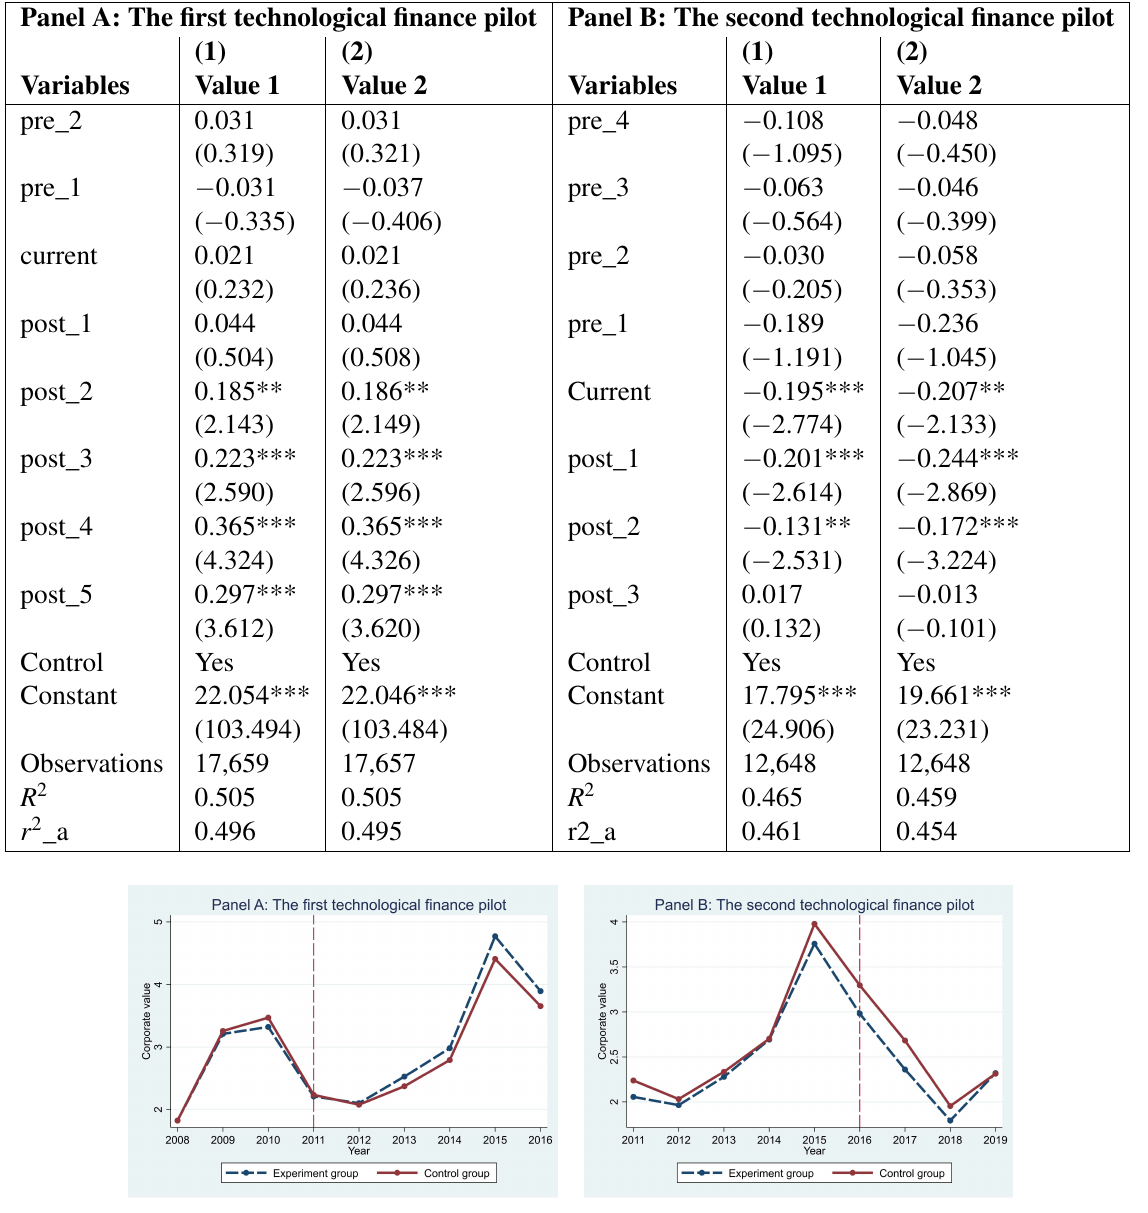
Fig. 1 The test chart of the common trend of two technological finance